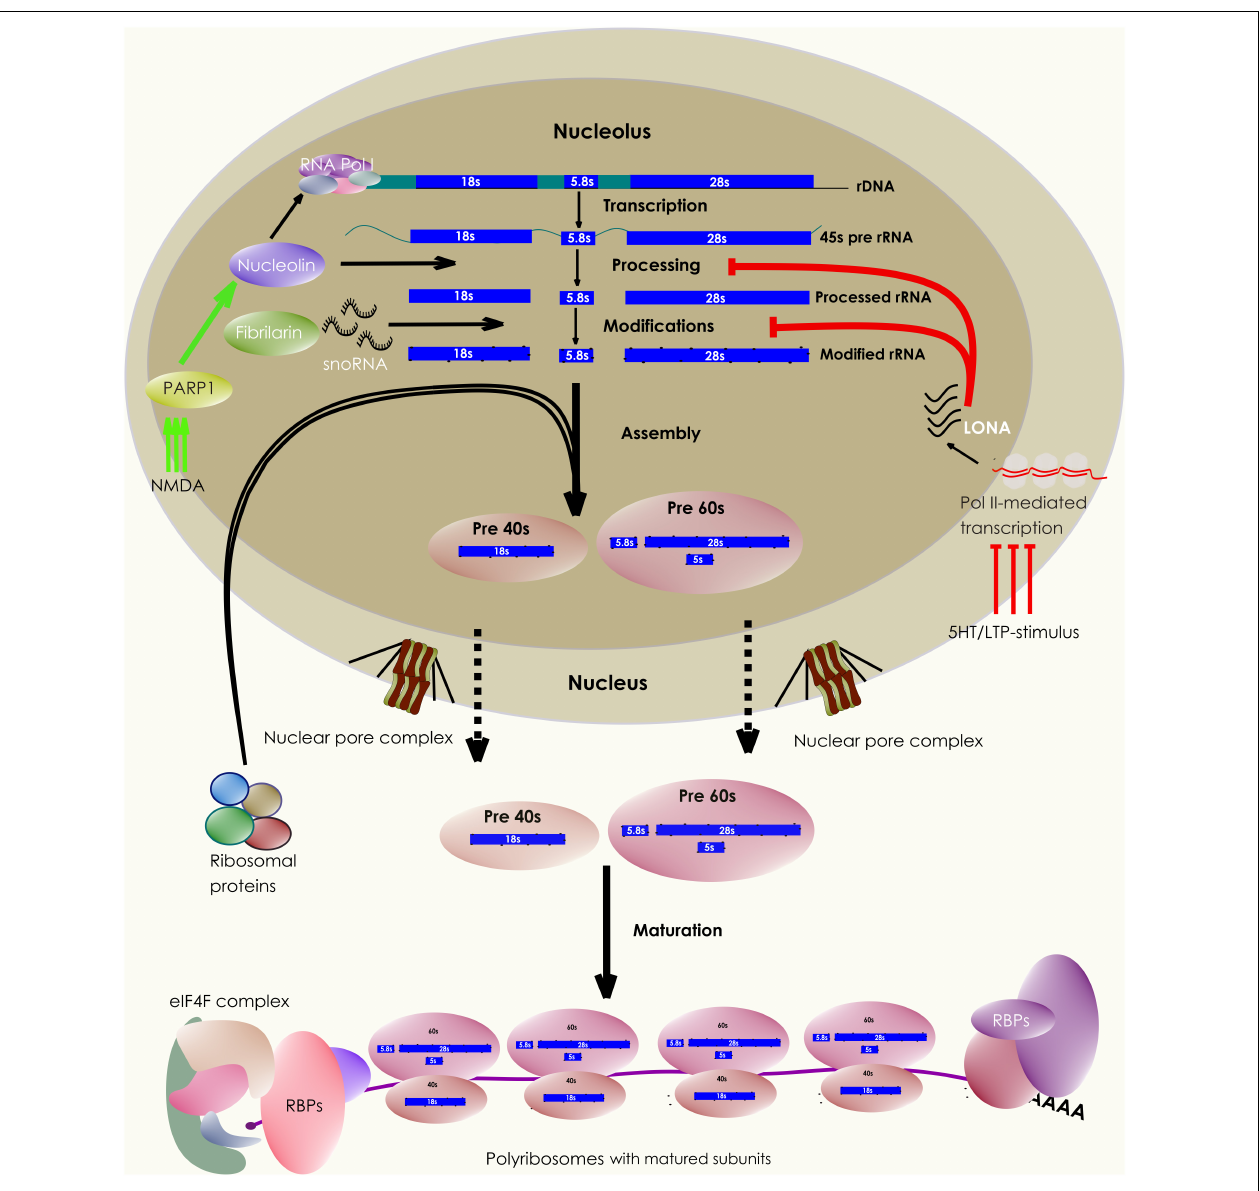
FIGURE 1 | Neuronal control of ribosome biogenesis. The schematic depicts various stages of ribosome biogenesis within the nucleolar compartment. The rRNA synthesis, modification, and maturation takes place in the nucleolus following which, they associate with ribosomal proteins produced in the cytosol. The assembled subunits are then exported out of the nucleus to undergo the final steps of cytoplasmic maturation. A pool of these matured subunits engages in translating mRNAs, a process facilitated by multiple other protein factors. Interestingly, the nucleolar biogenesis process can be influenced by synaptic stimulation through a variety of synapse to nucleus (retrograde) signaling